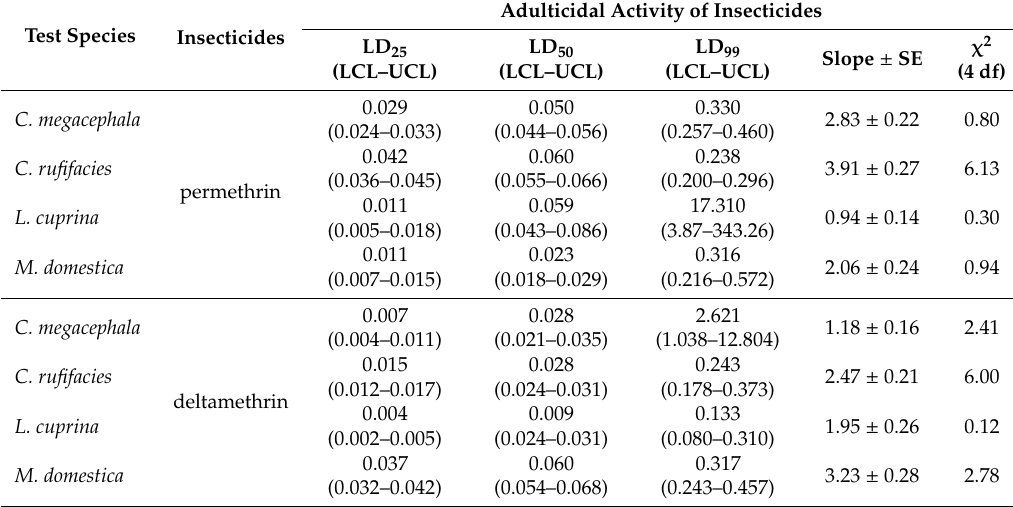
Table 6. The adulticidal activity of insecticides against the blow flies and the house fly. Test